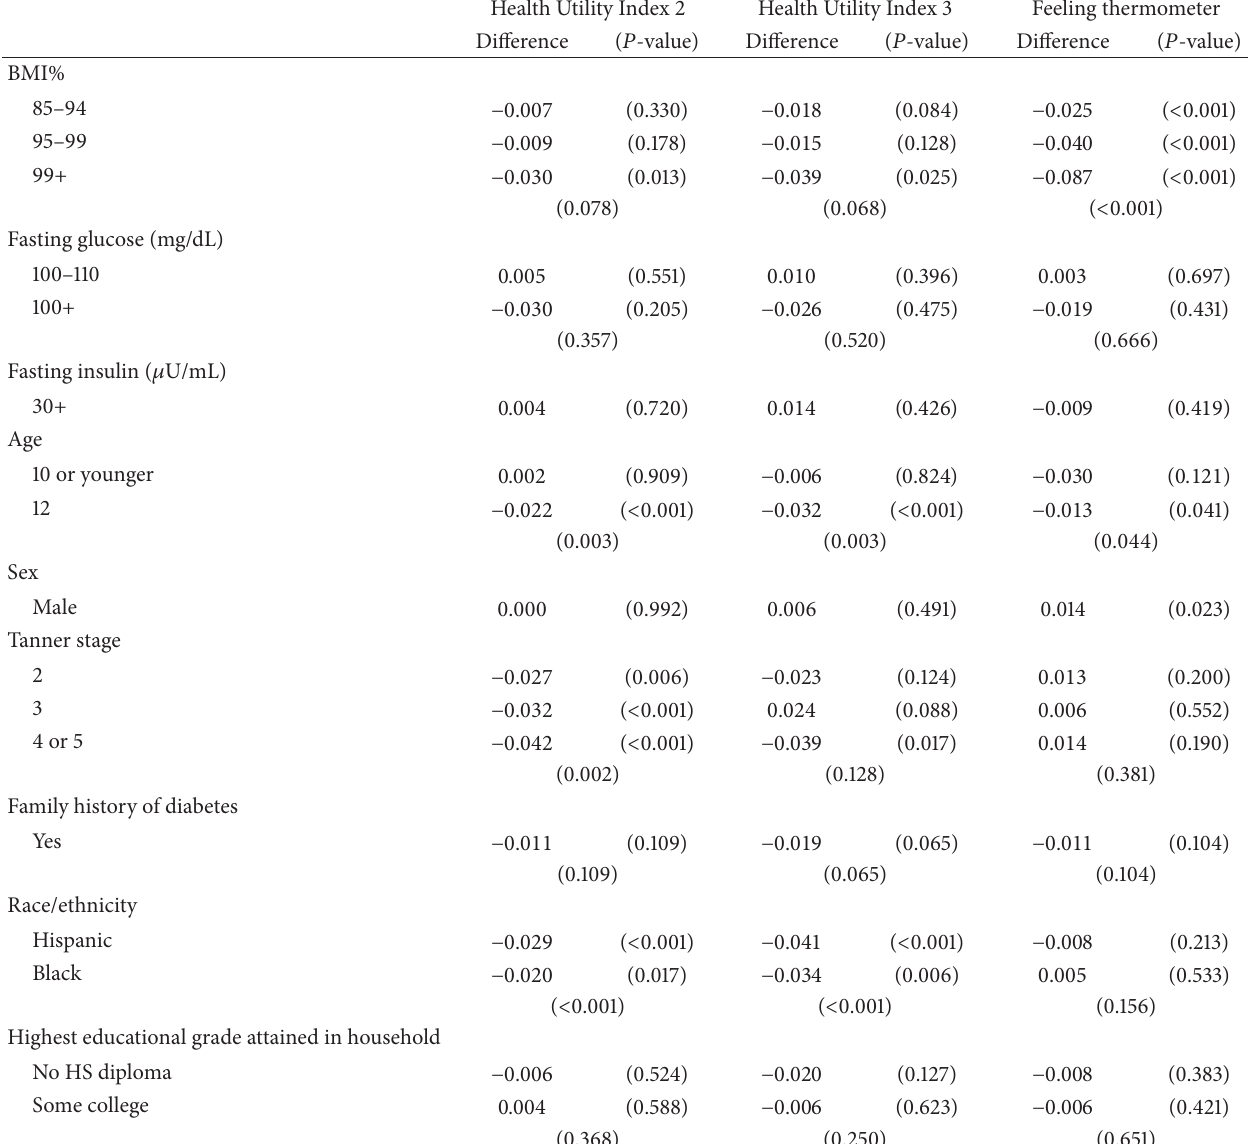
Table 3: Adjusted ∗ differences of preference-weighted QOL scores by clinical and demographic characteristics compared with reference categories ∗∗